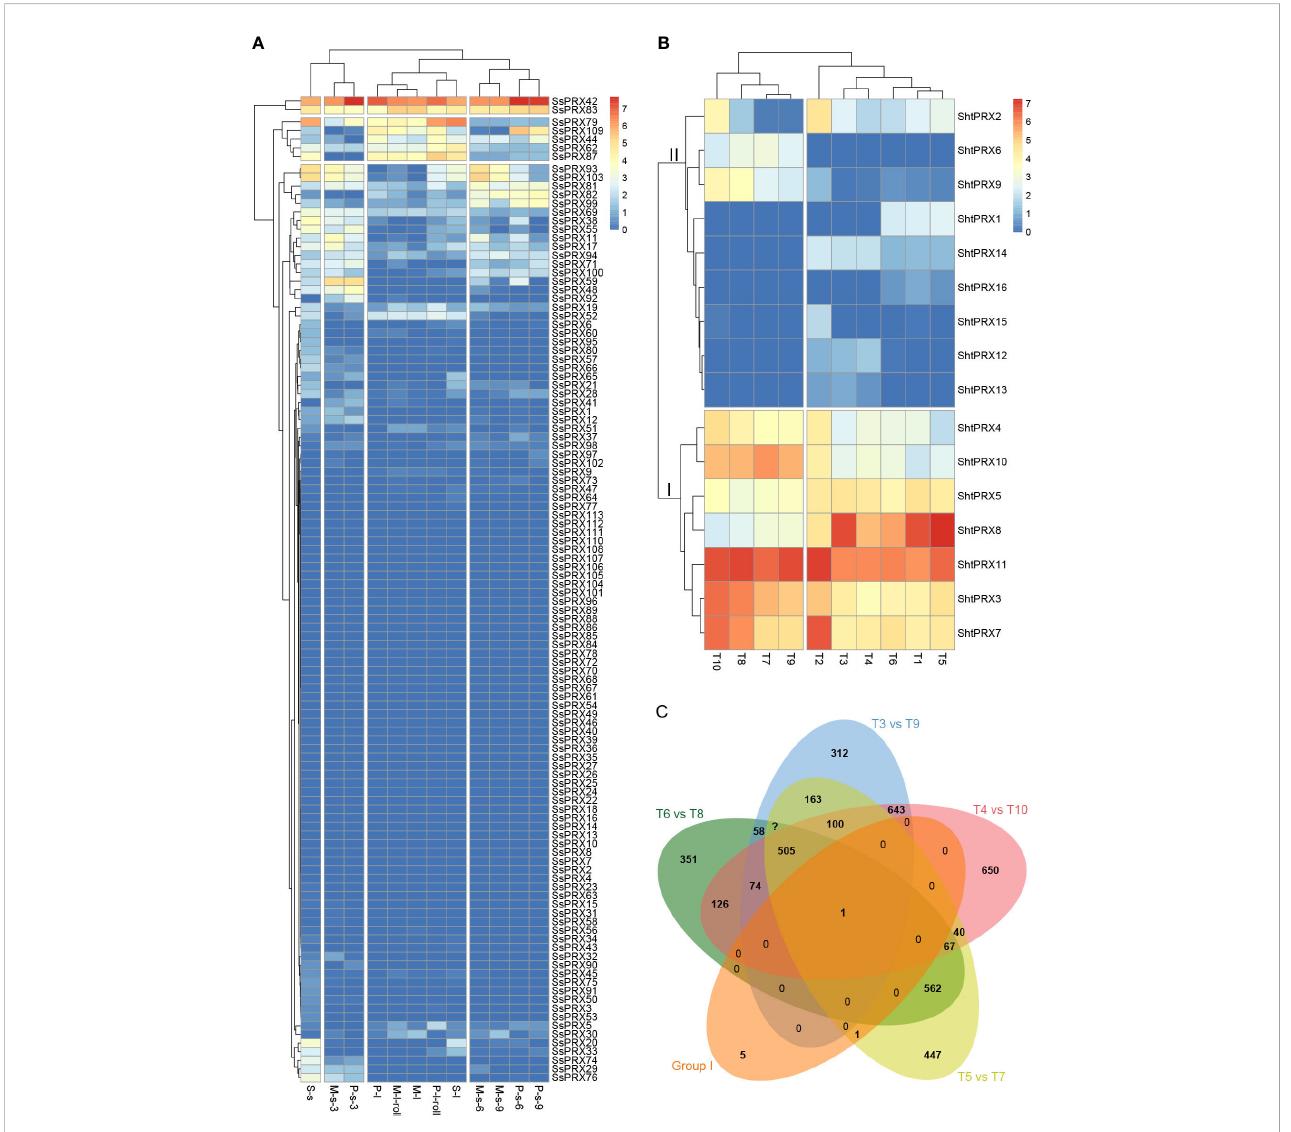
FIGURE 6 Expression pattern of the PRX genes in sugarcane. (A) Tissue-speci fi c expression patterns of PRX gene family in S. spontaneum . S represents seedling; s represents stem; l represents leaf; P represents early maturity stage; M represents mature stage; 3, 6, and 9 represent sugarcane ’ s third, sixth, and ninth stem nodes. (B) Expression patterns of PRX gene family of sugarcane in response to SCMV infection. T1, the +1 leaf of Badila; T2, the − 3 leaf of Badila; T3, the +1 leaf of virus-free Badila; T4, the − 3 leaf of virus-free Badila; T5, the +1 leaf of B48; T6, the − 3 leaf of B48; T7, the +1 leaf of B48 post-SCMV infection; T8, the − 3 leaf of B48 post-SCMV infection, T9, the +1 leaf of virus-free Badila post-SCMV infection; T10, the − 3 leaf of virus-free Badila post- SCMV infection. (C) The number of co-differentially expressed genes in groups I, T6_vs_T8, T3_vs_T9, T4_vs_T10, and